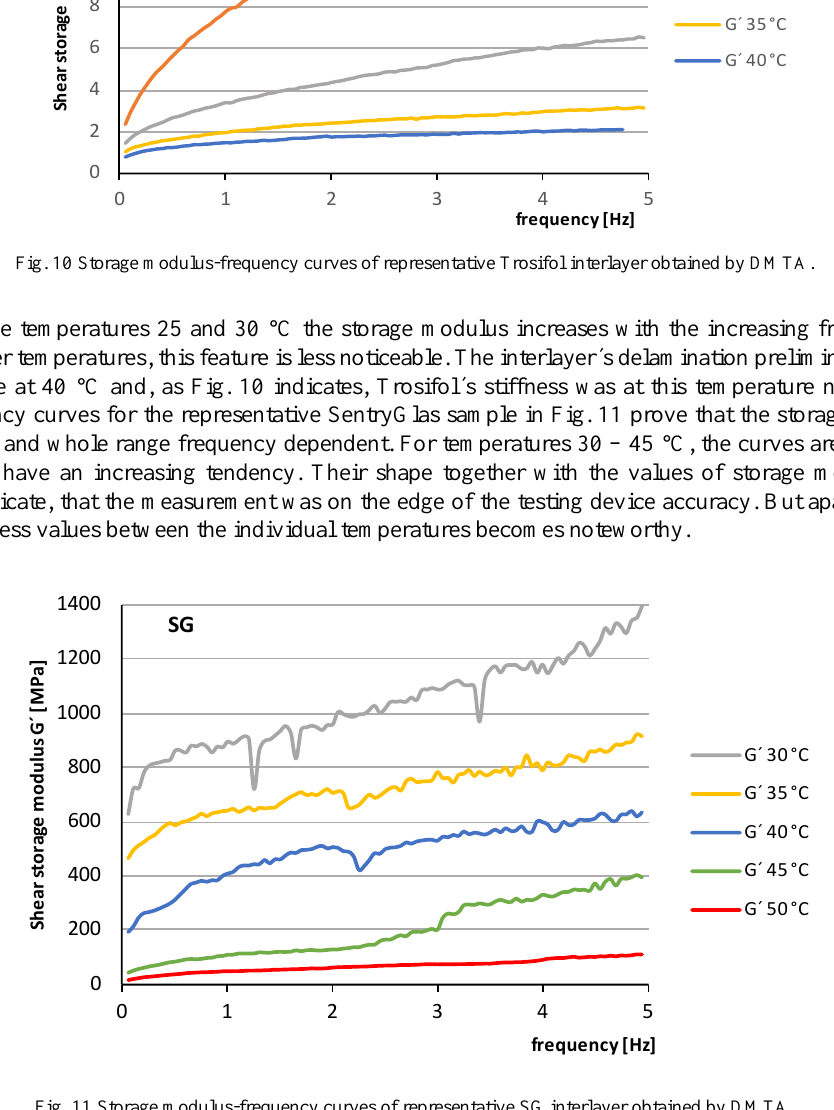
Fig. 11 Storage modulus-frequency curves of representative SG interlayer obtained by